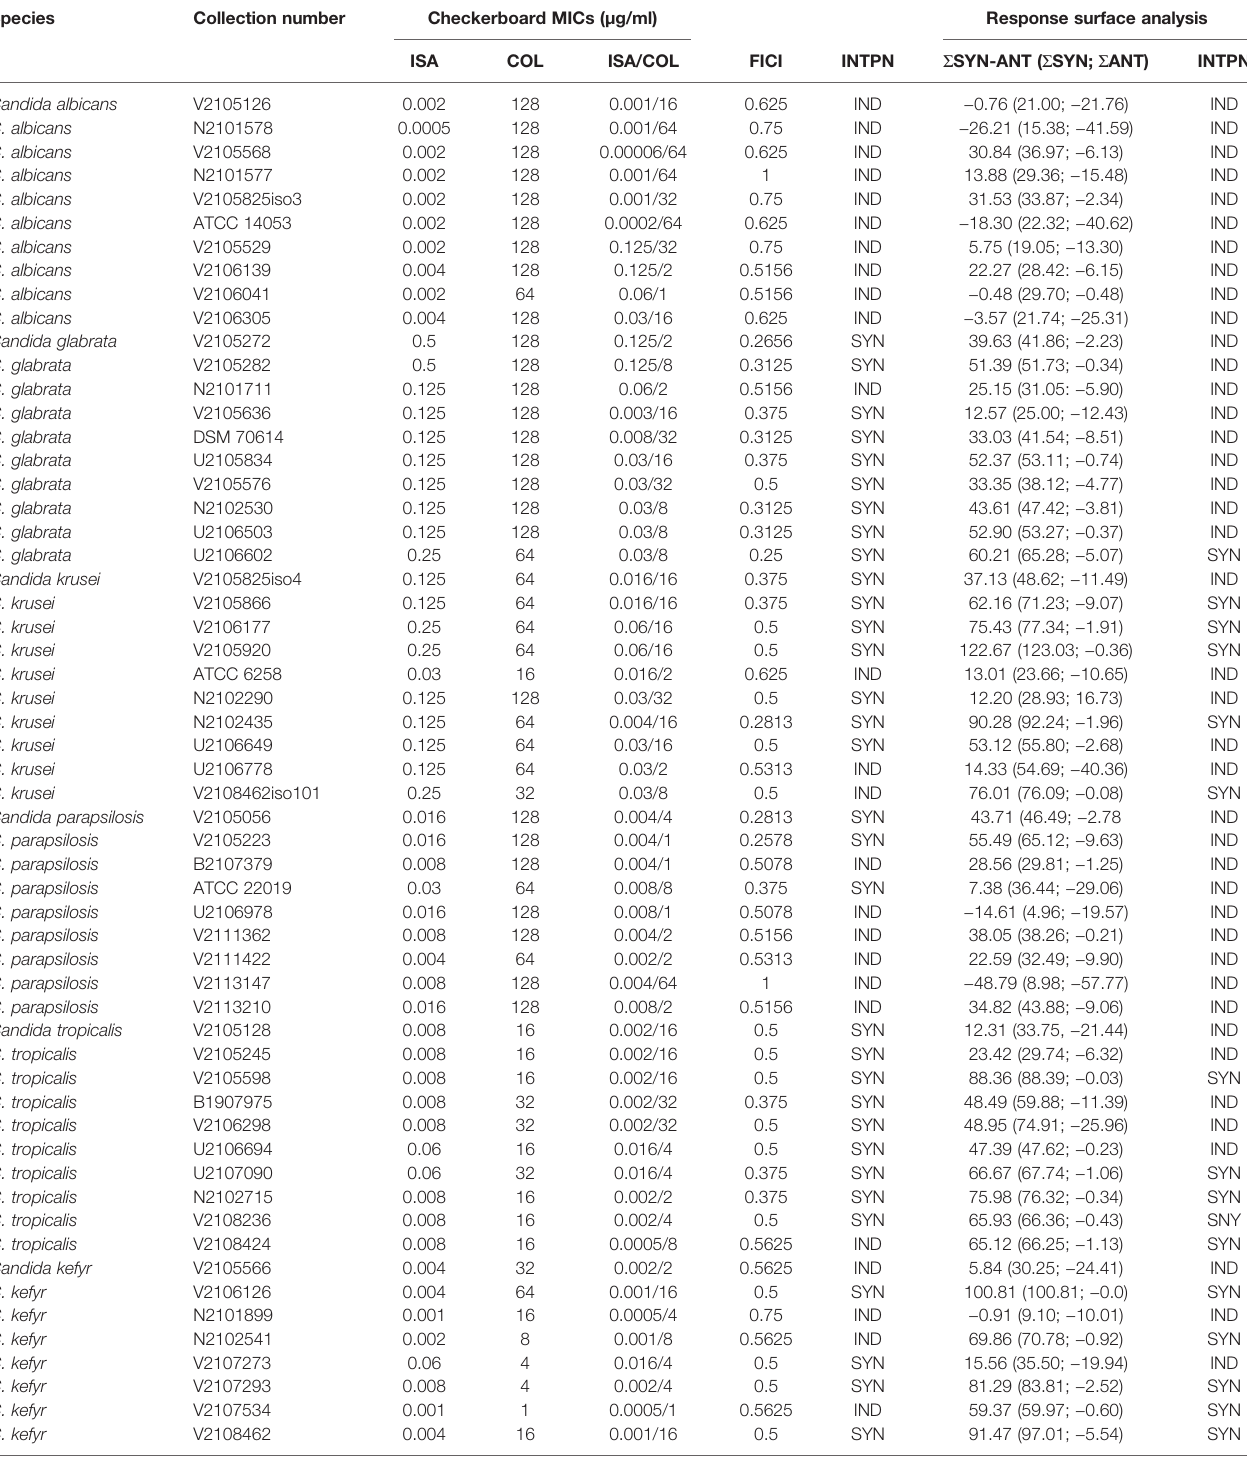
FICI, fractional inhibitory concentration index; INTPN, interpretation; SYN, synergy; IND, no interaction; ISA, isavuconazole; COL, colistin; ATCC, American Type Culture Collection; DSM, Deutsche Sammlung von Mikroorganismen und Zellkulturen; MIC, minimum inhibitory